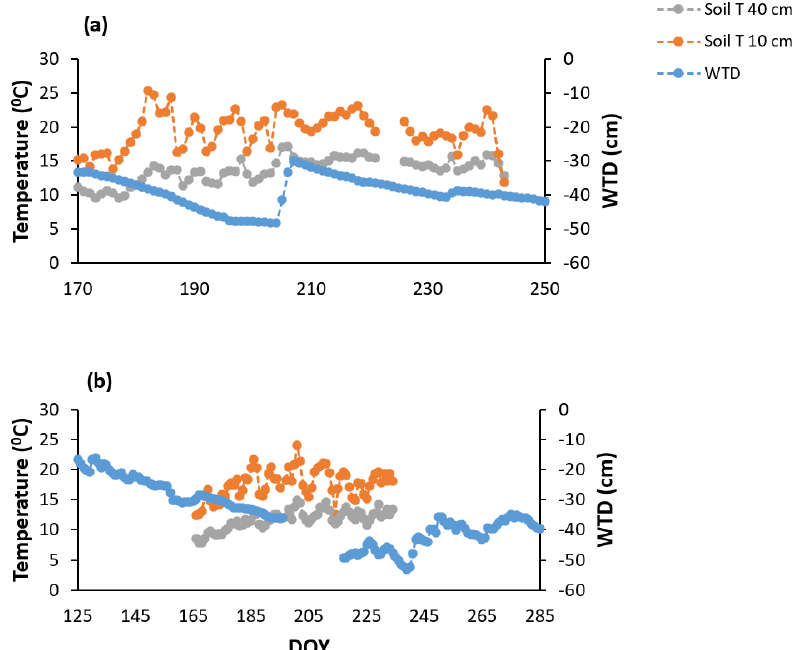
Figure A1. Continuous measures of soil temperatures (soil T ) at 10 and 40cm and water table depth (WTD) for the growing seasons of (a) 2018 and (b) 2019 derived from the eddy covariance tower near the manual chamber